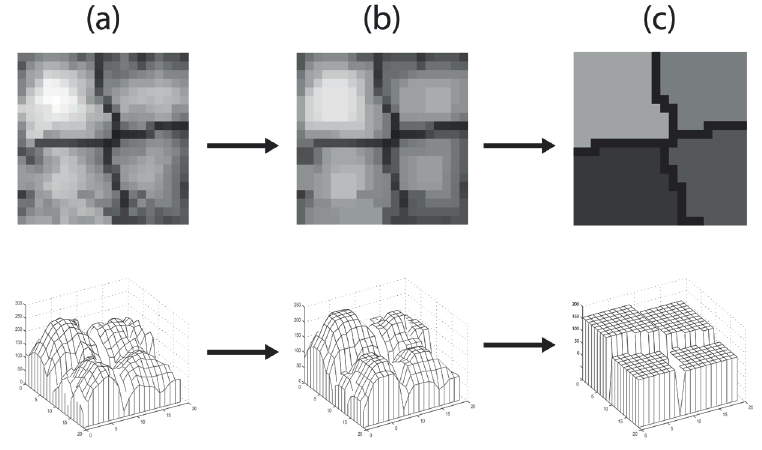
Fig. 7. Watershed transformation: (a) PDF, (b) opening PDF, (c) PDF modal